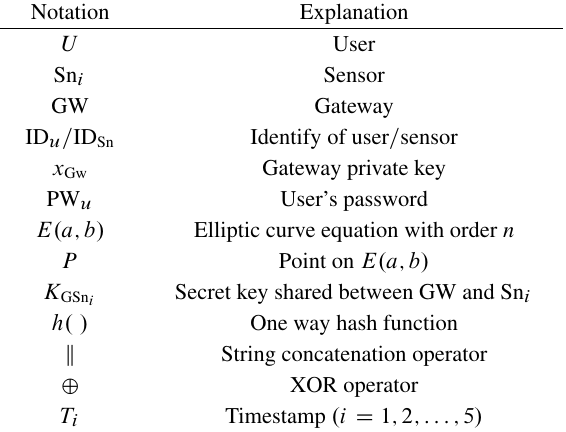
Symbolizations and their